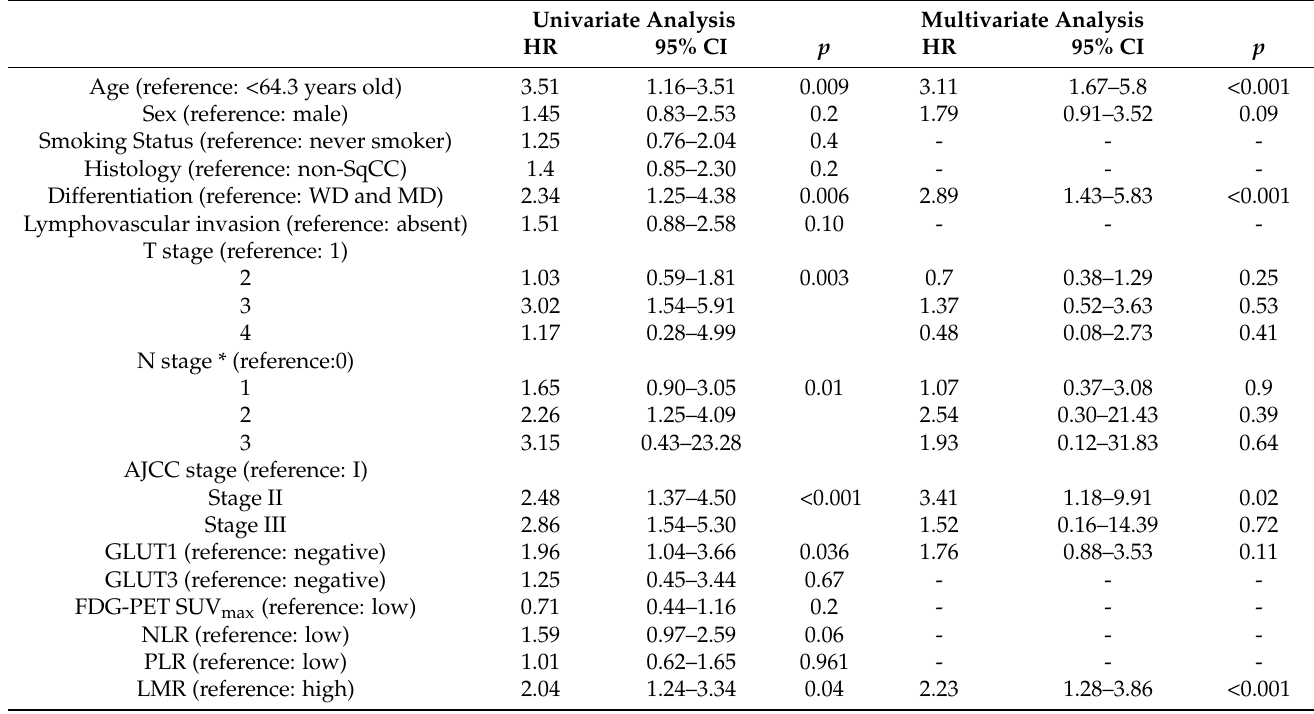
Table 3. Univariate and multivariate Cox regression analysis for overall survival in 137 Stage I, II and III non-small cell lung cancer